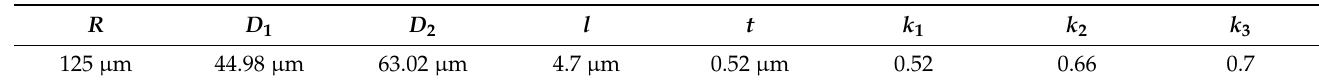
Table 1. Parameter settings when calculating the influence of various g on CL and the cou- pling